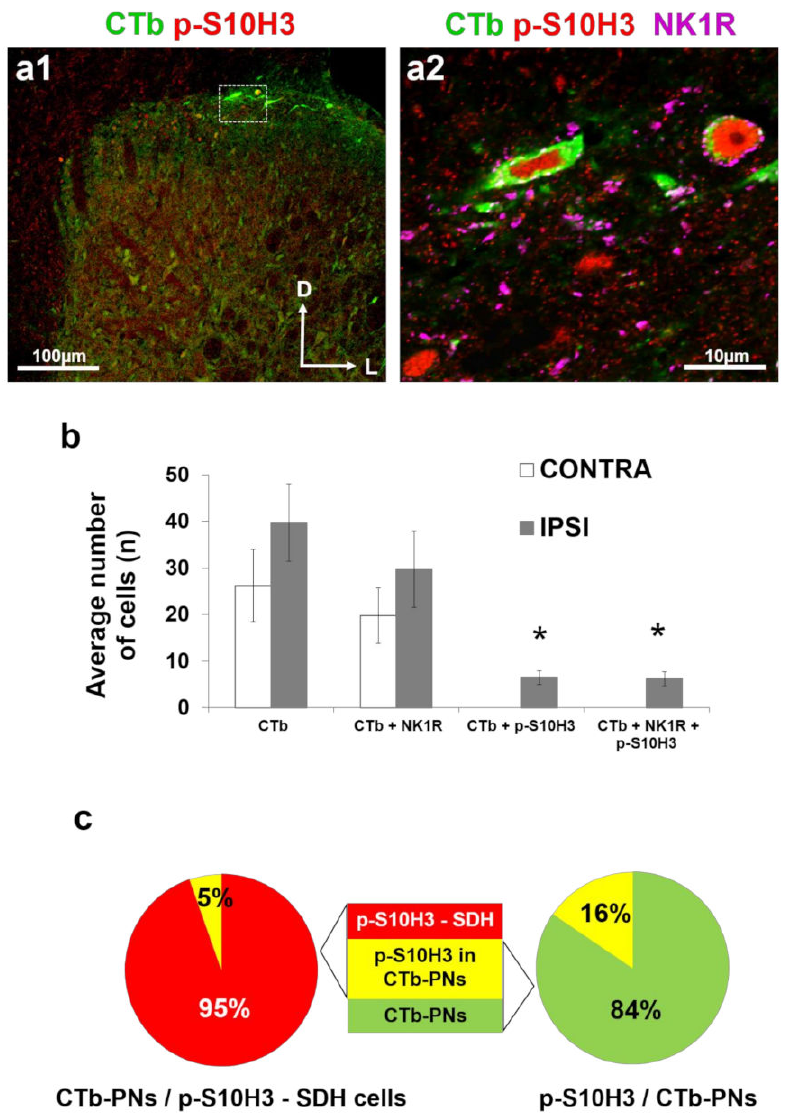
Figure 4. cholera toxin b-subunit (CTb)-labeled projection neurons rarely show nuclear burn injury- induced p-S10H3. ( a1 , a2 ) Immunostaining with antibodies against p-S10H3 (red), CTb (green) and neurokinin-1 receptor (NK1) receptor (NK1R; magenta) in an L5 transverse spinal cord section of a rat after burn injury. ( a2 ) Higher magnification image represents the region with two CTb-labeled projection neurons (PNs) outlined by dashed line in ( a1 ). These two CTb/p-S10H3 co-labeled neurons express NK1R. ( b ) Average number of CTb-labeled projection neurons (PNs) containing p-S10H3 positive nuclei and NK1R immunoreactivity (n = 17, 80- µ m-thick sections per rat from 4 rats). IPSI refers to the side of the burn injury. Asterisks indicate a statistically significant difference between the ipsi- and contralateral sides of SDH (* p < 0.05). Note that the numbers of CTb-PNs with p-S10H3 or CTb/p-S10H3/NK1R ipsilaterally are negligible. Note also that the CTb-PNs could be detected on both sides. ( c ) Percentage of CTb-PNs within the total p-S10H3 positive SDH cell population (left) and percentage of PNs with p-S10H3 positive nuclei within the total CTb labeled PN population in the SDH